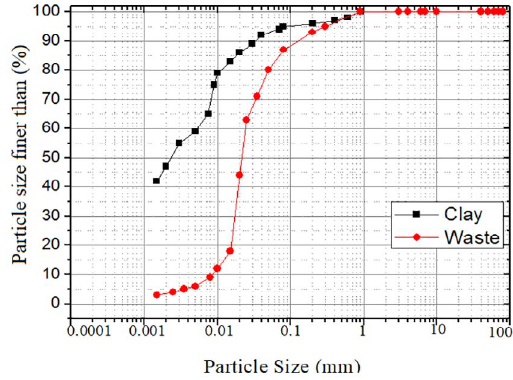
Figure 4. Particle size distribution of clay and the Sulfatreat waste.